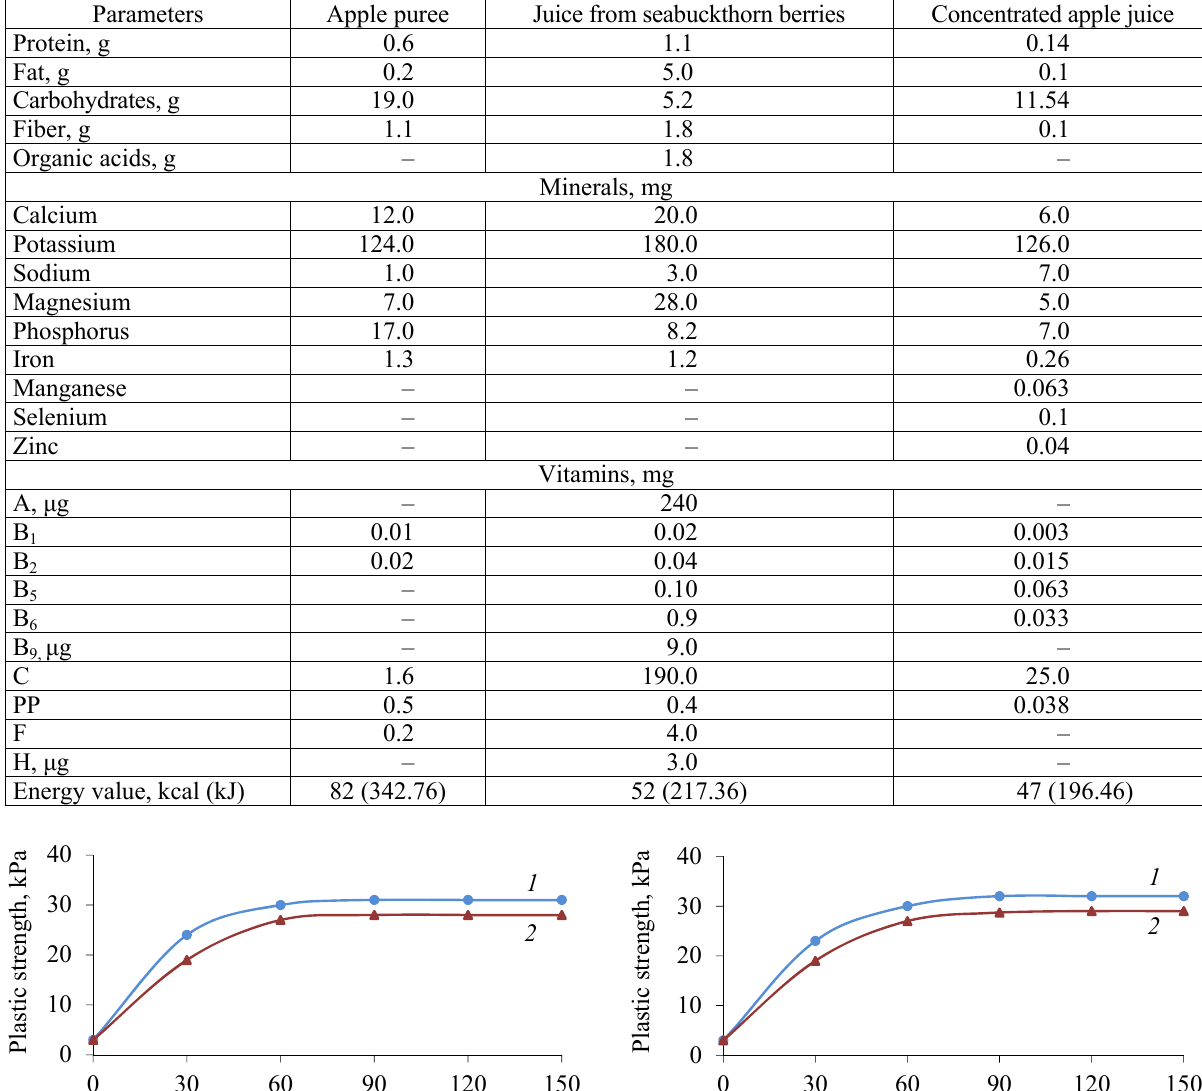
1 Table 1. Chemical composition and energy value of enrichers